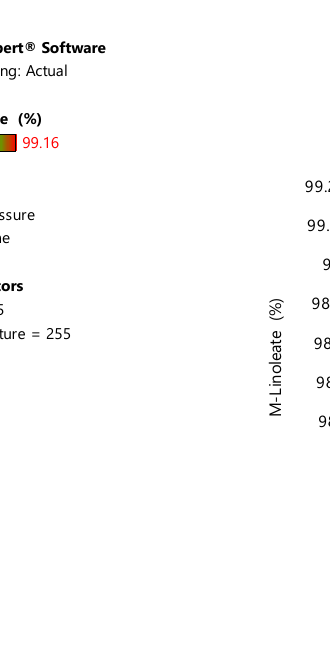
Figure A10. Response surface and contour plot for the effect of reaction pressure and time on the yield of methyl-palmitate.